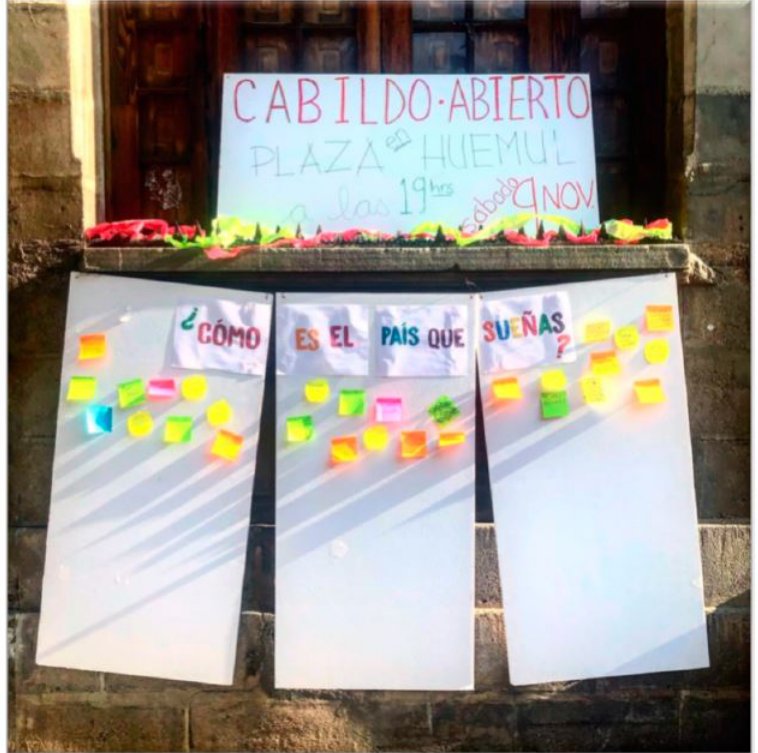
3 November 2019 – Plaza Huemul – The Huemul Neighbourhood Assembly promoting the planned community cabildo at an outdoors community musical event. The community question board asks: What type of country do you dream of? (Source: Author,